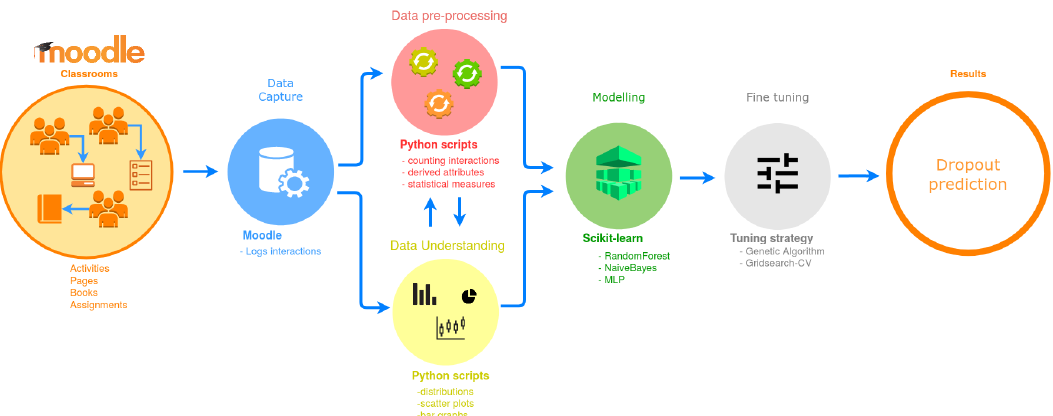
Figure 1. Proposed approach.